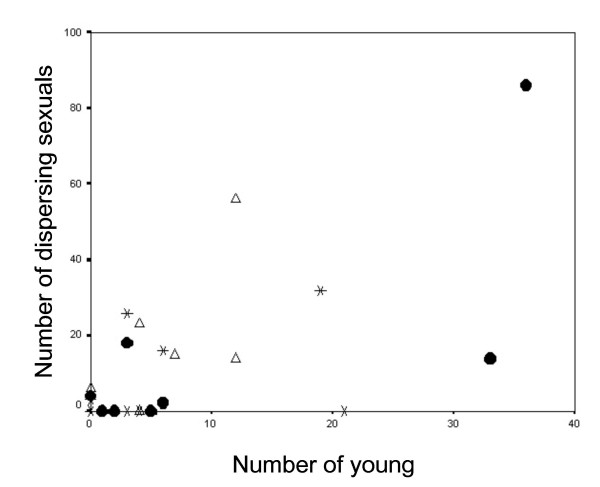
Number of dispersing individuals in relation to number of young instars present in a colony. Filled circles: control colonies; asterisks: colonies in which young individuals were added; open triangles: colonies in which individuals were added, but the age composition of the colony was not changed.